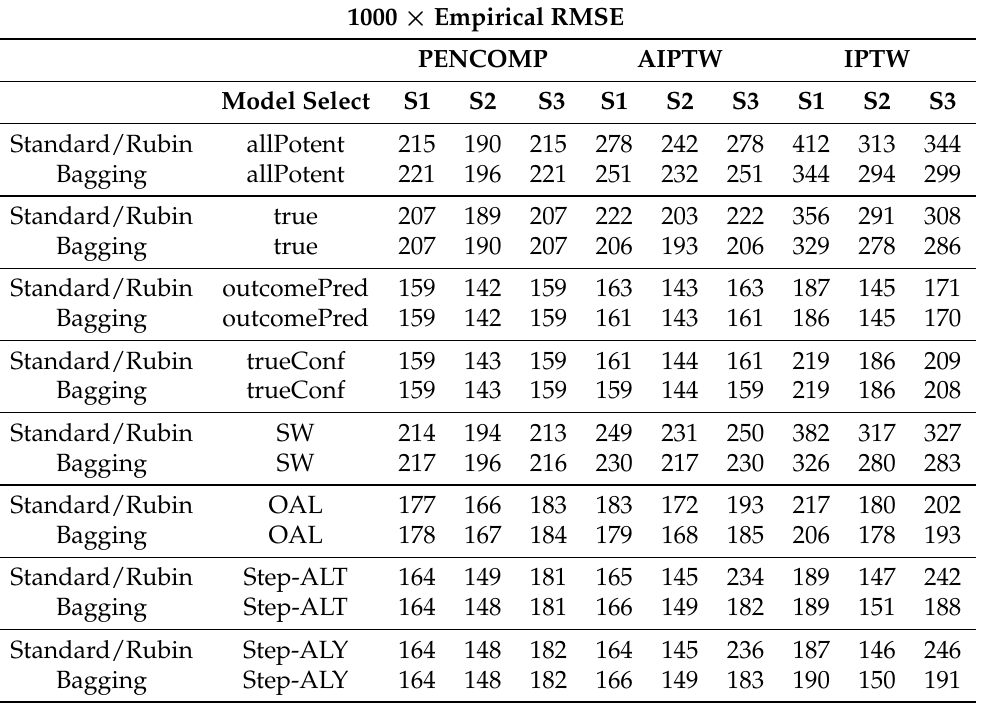
Table 1. 1000 × RMSE with sample size of 200. The treatment effects η = 2. S1, S2, and S3 denote scenario 1, 2, and 3, respectively.